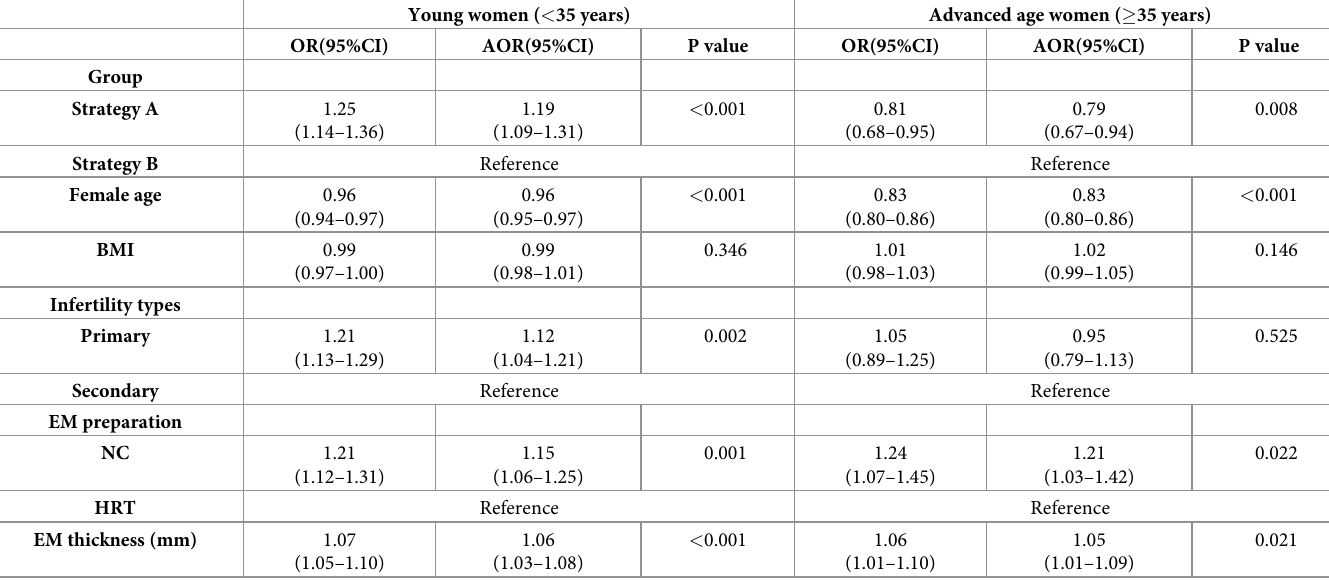
Table 3. Regression analysis for the live birth rate per thaw